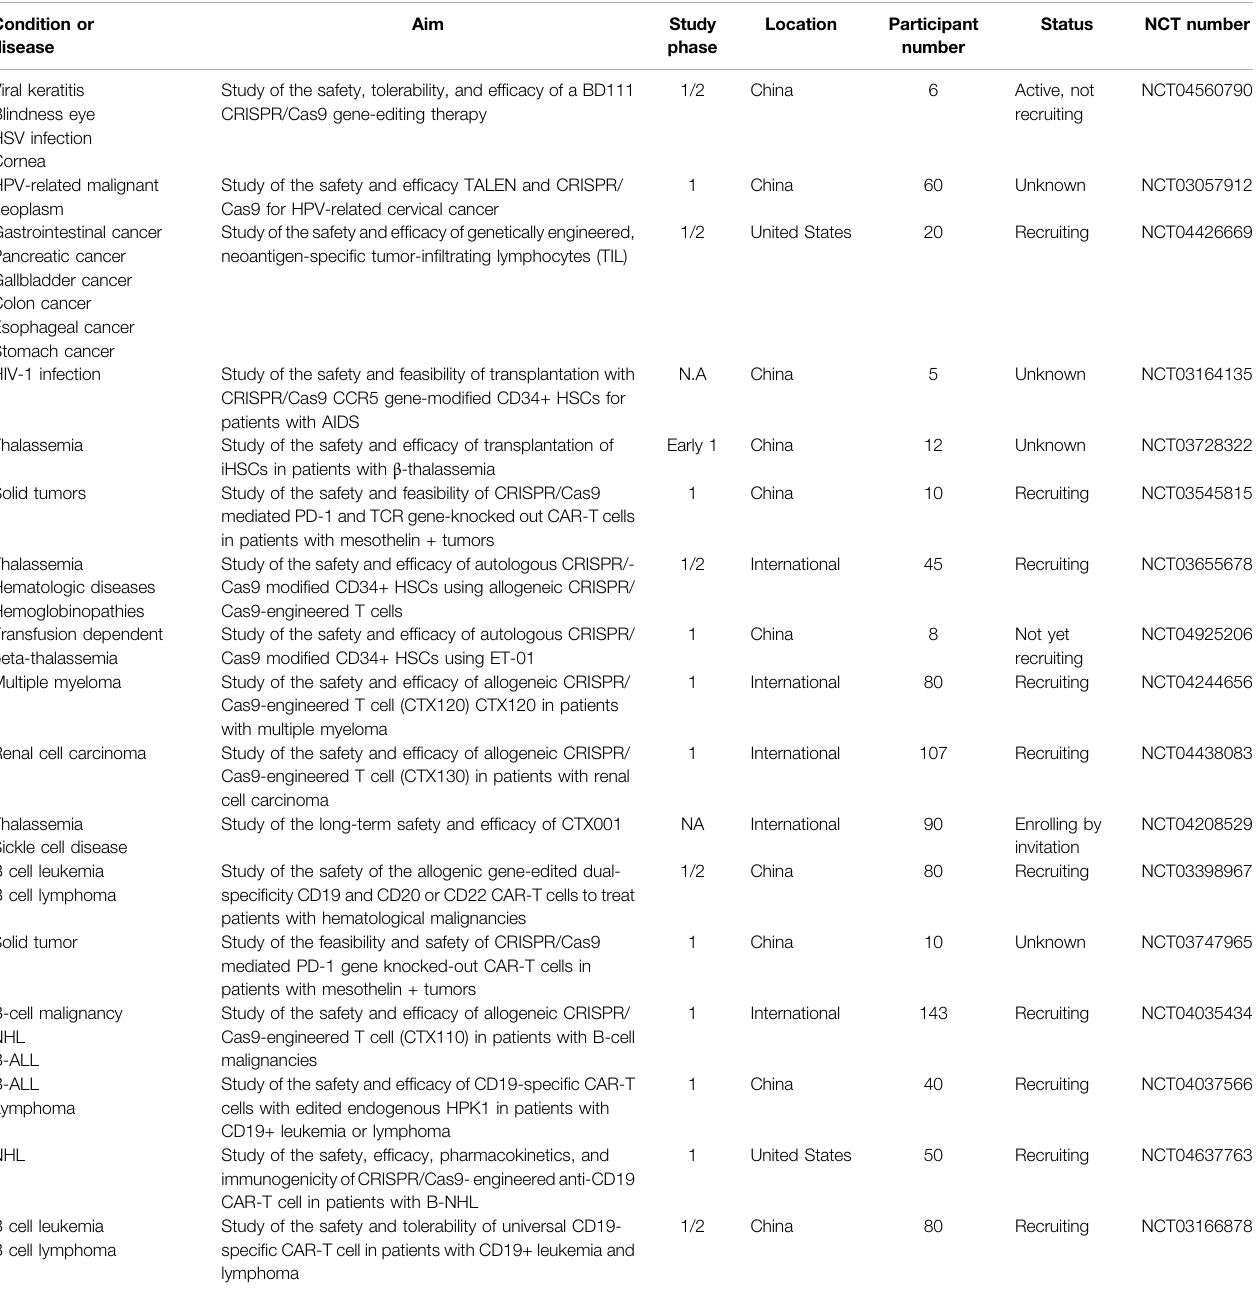
TABLE 4 | Clinical trials based on CRISPR/Cas9 application in